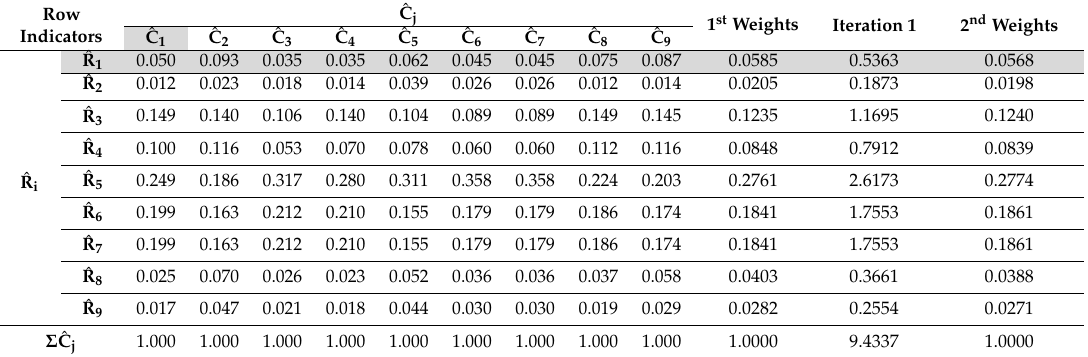
Table 5. Example normalised matrix of pairwise comparisons for stakeholder B. ˆ C Row j 1 st Weights Iteration 1 2 nd Weights ˆ C Indicators